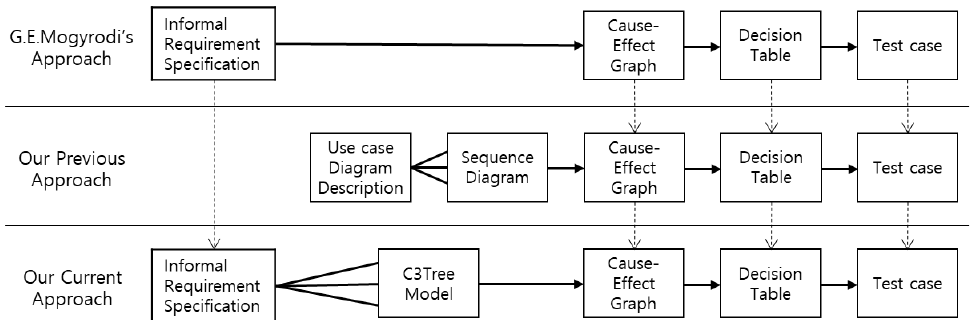
Figure 1. Automatic cause – effect design mechanism for test cases. Table 1. The comparison with the existing tools.